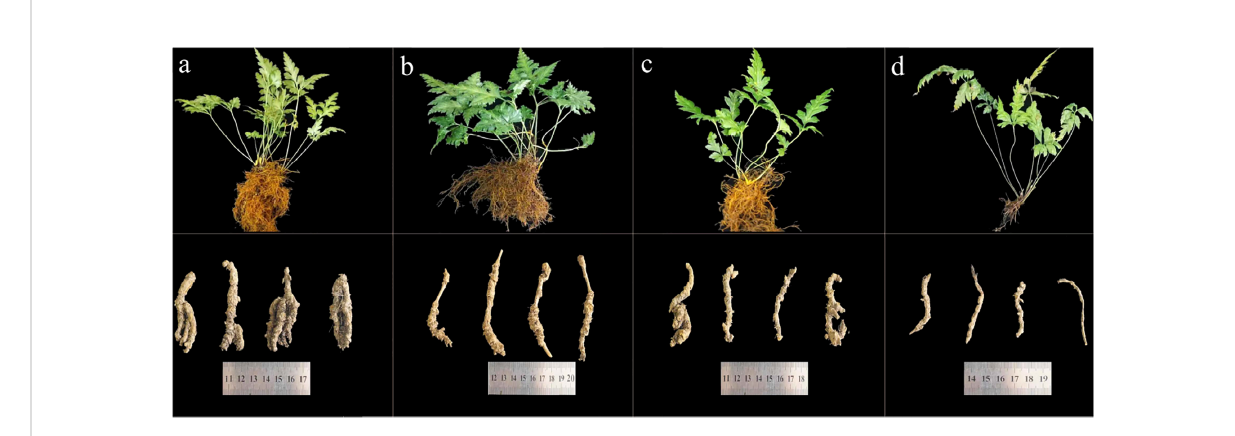
FIGURE 1 The images of RC materials. (A) C. chinensis species and its root and rhizome; (B) C. deltoidea species and its root and rhizome; (C) C. omeiensis species and its root and rhizome; (D) C. teeta species and its root and